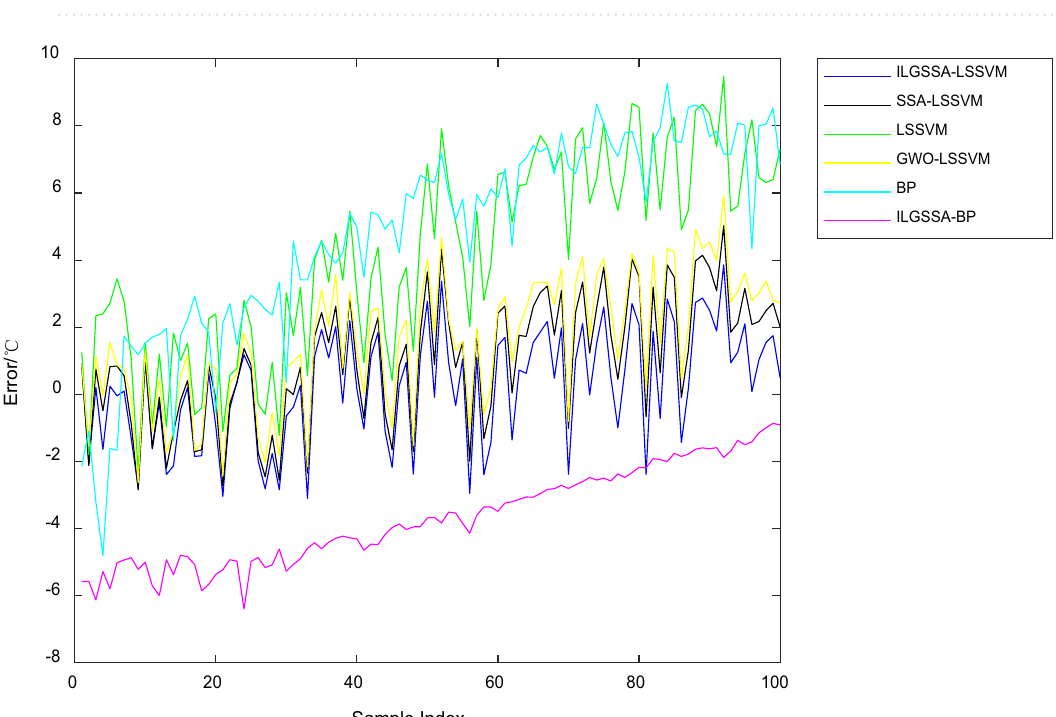
Figure 6. Comparison diagram of soft sensing results.